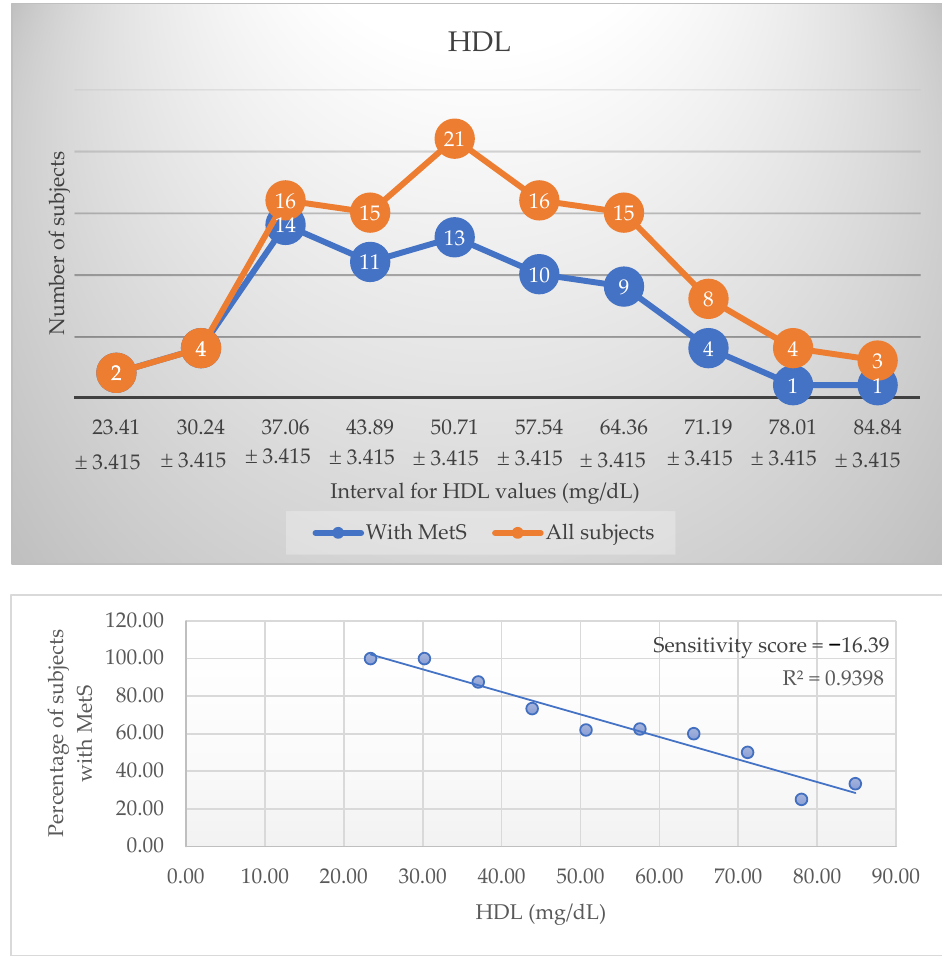
Figure 1. Distribution and prevalence charts for HDL.